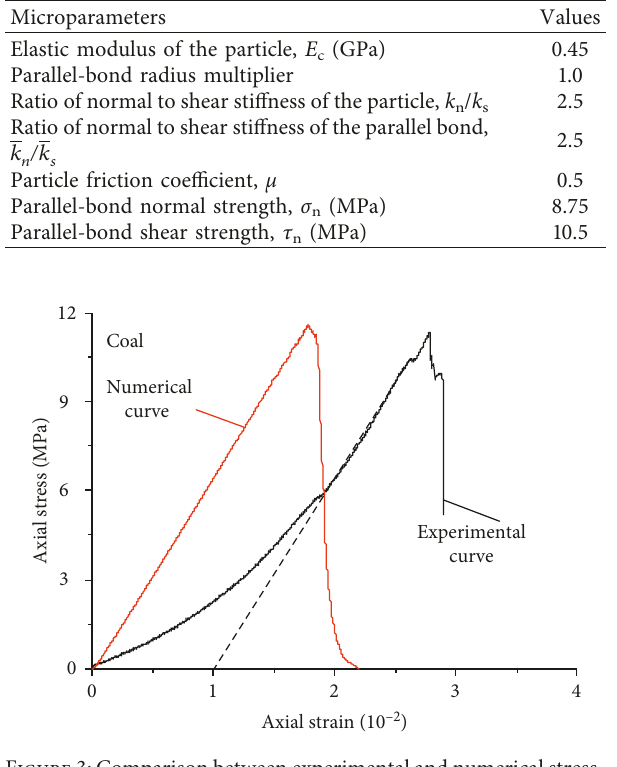
Figure 3: Comparison between experimental and numerical stress- strain curves of coal under uniaxial compression.